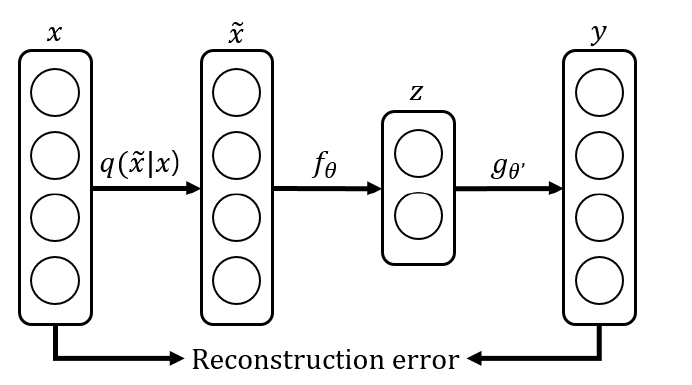
Figure 5. The mathematical operation flow in